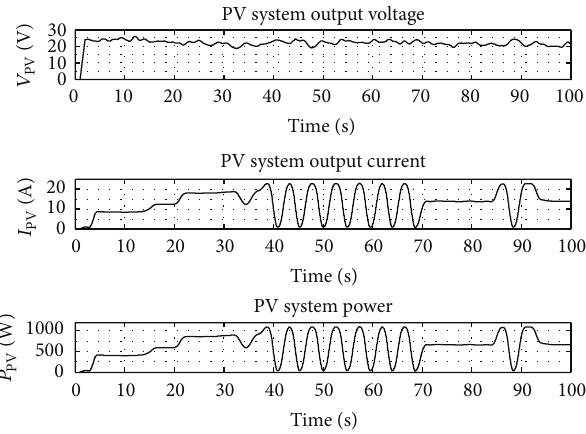
Figure 17: Voltage, current, and power change of PV solar panels for case 1.